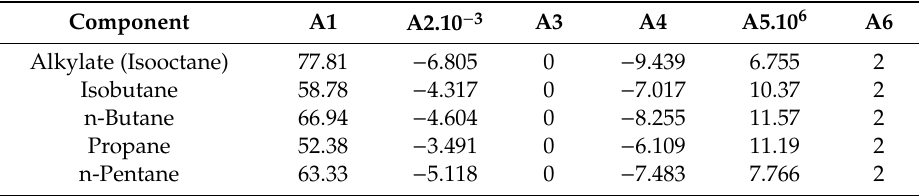
Table 2. Vapor pressures. Coe ffi cients obtained from [49].